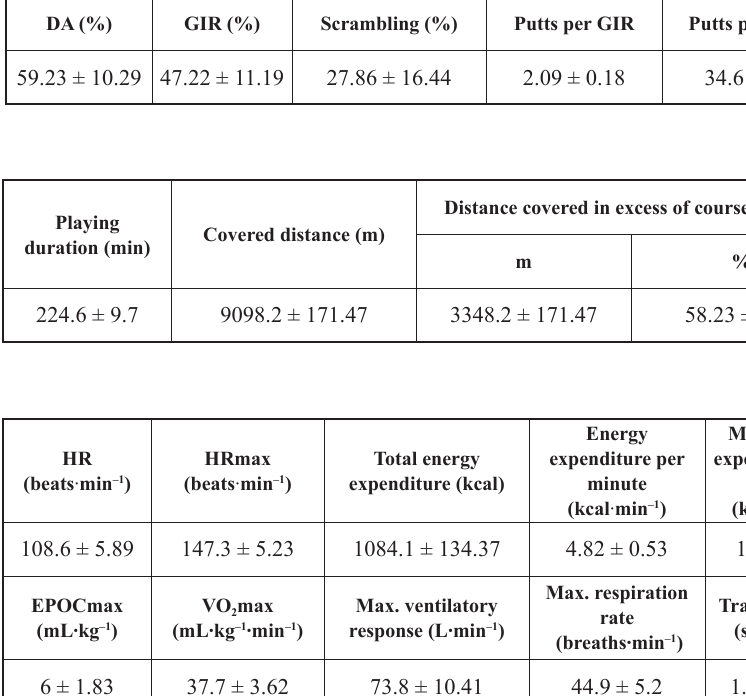
Table 2. Sport Performance Indi- cators of Youth Golfers